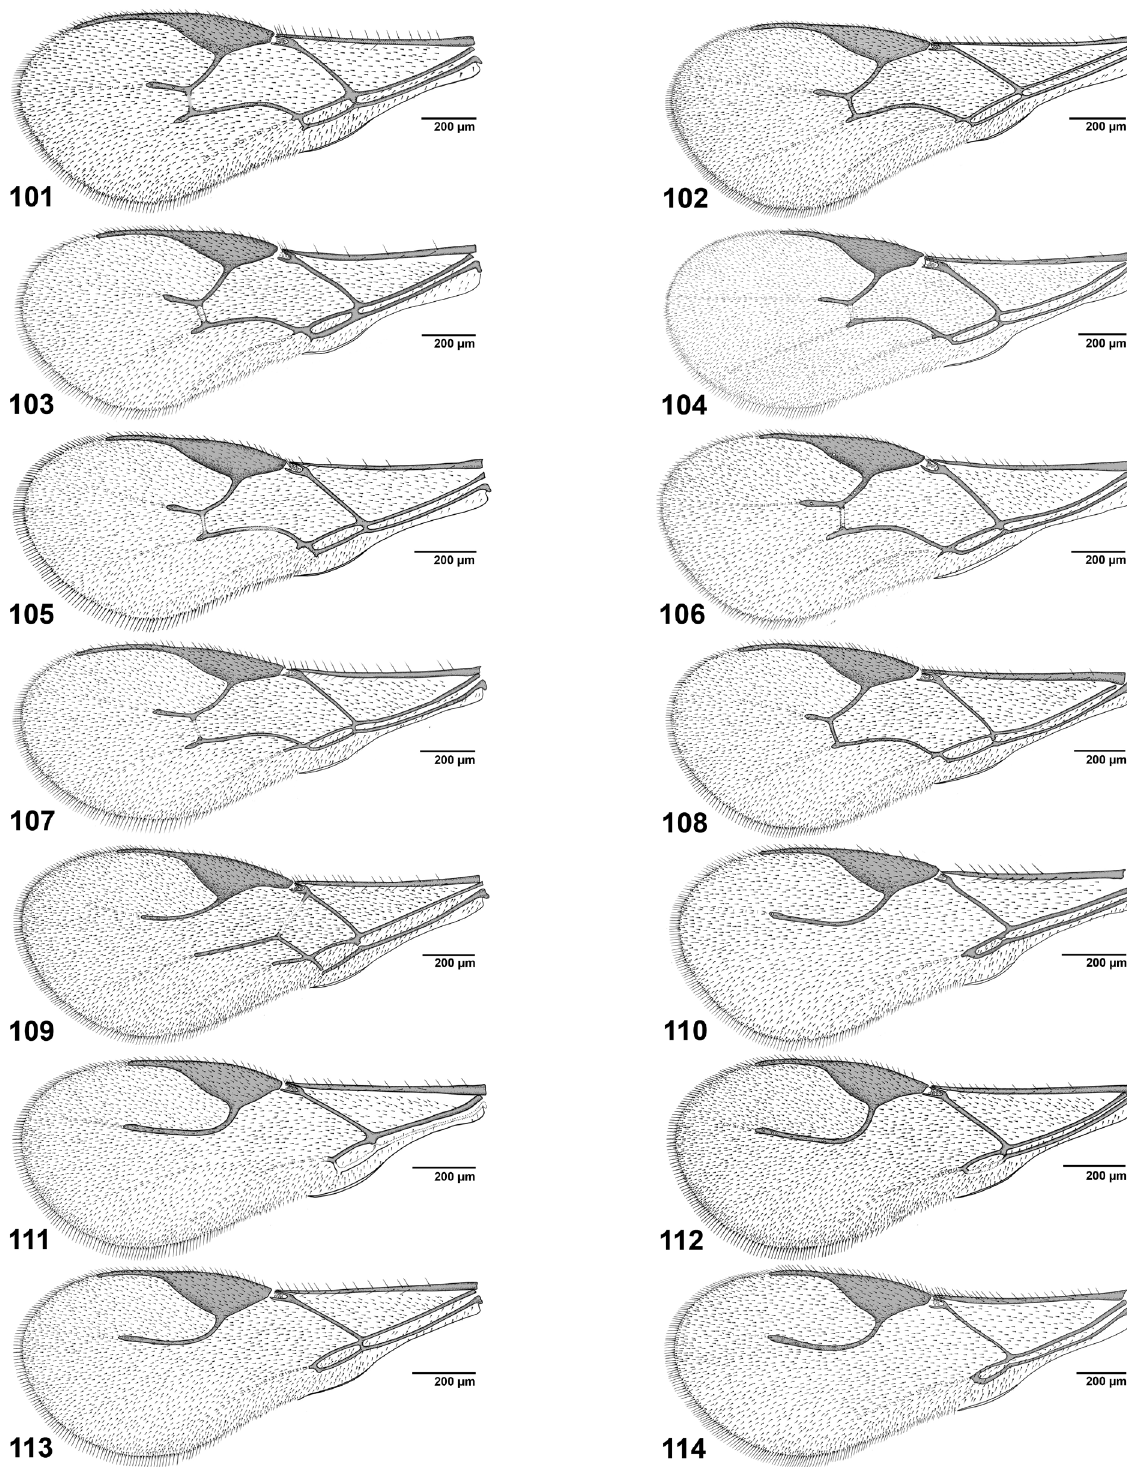
Figs 101–114. Forewing (♀): 101 . Aphidius setiger . 102 . Aphidius smithi . 103 . Aphidius sonchi . 104 . Aphidius stigmaticus . 105 . Aphidius transcaspicus . 106 . Aphidius uroleuci . 107 . Aphidius urticae . 108 . Aphidius uzbekistanicus . 109 . Areopraon lepelleyi . 110 . Betuloxys hortorum . 111 . Binodoxys acalephae . 112 . Binodoxys angelicae . 113 . Binodoxys brevicornis . 114 . Binodoxys centaureae